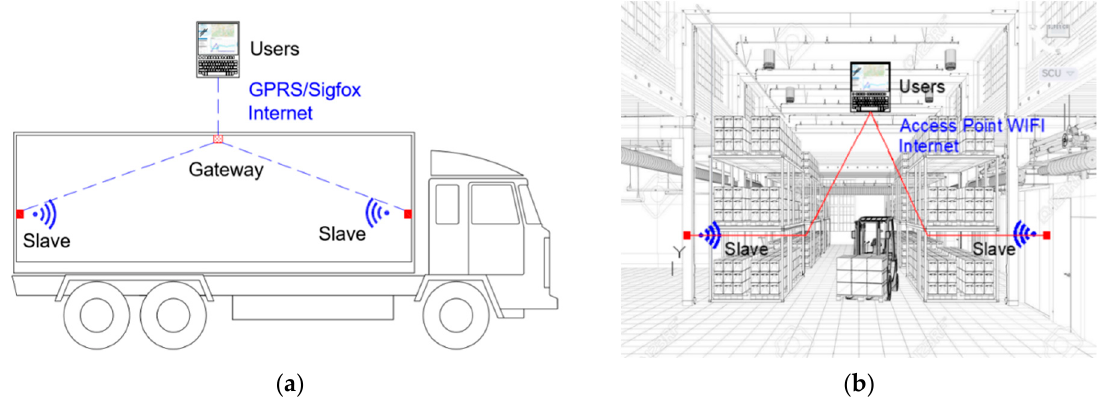
Figure 1. ( a ) Two slave nodes are communicating with one gateway node, which provides the cloud access; ( b ) two slave nodes are sending the measured information to the cloud servers through an existing Wi-Fi infrastructure.